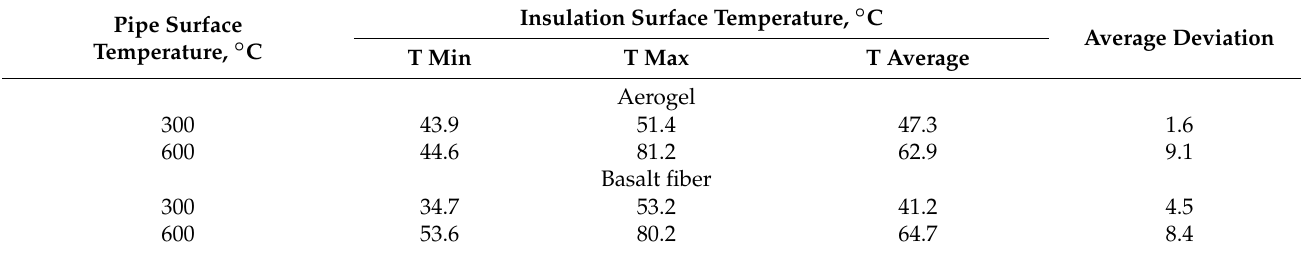
Table 1. The results of measurements.